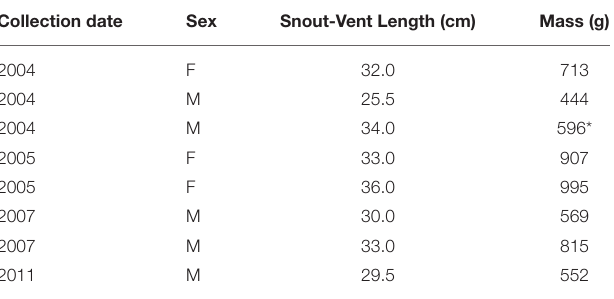
TABLE 1 | Collection and demographic data for hellbender broodstock. TABLE 2 | Ethogram of behaviors recorded during video